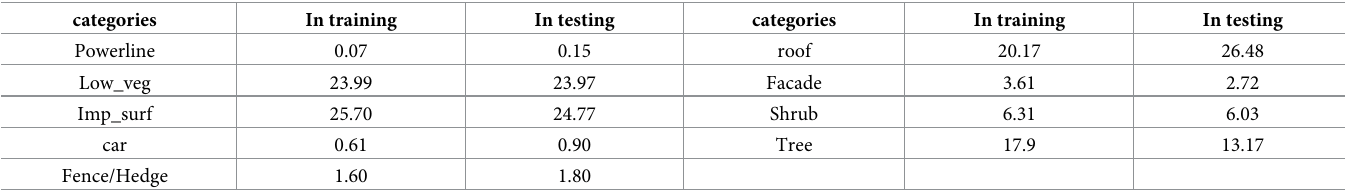
Table 1. The percent of different categories in ISPRS vaihingen benchmark dataset. categories In training In testing categories In training In